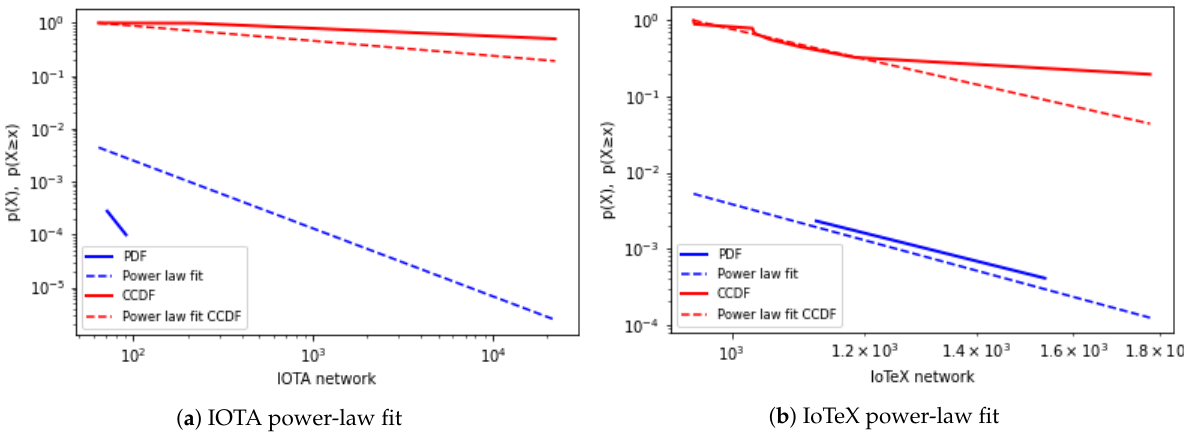
Figure 12. Power-law fit using Python powerlaw library by Alstott et al. IOTA and IoTeX datasets.